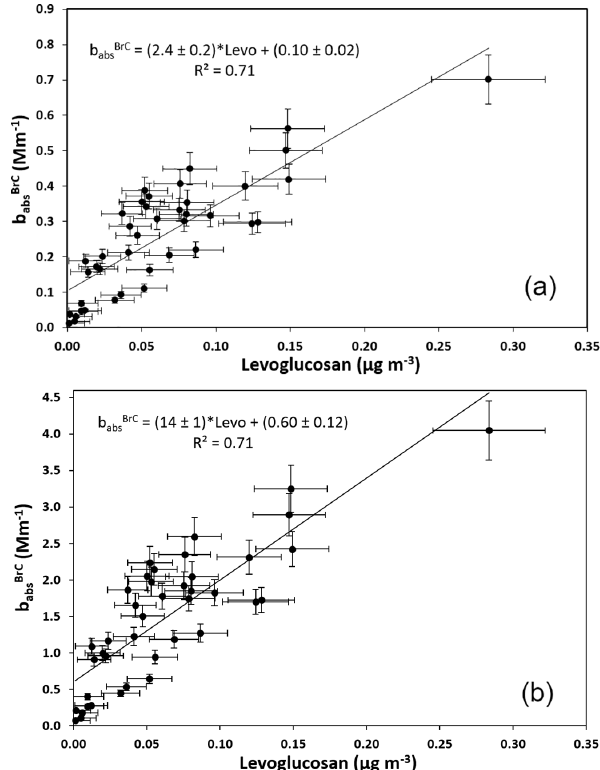
Figure 6. Aerosol absorption coefficient apportioned to brown car- bon ( b BrC ) at λ = 635 (a) and at λ = 405nm (b) vs. levoglucosan abs